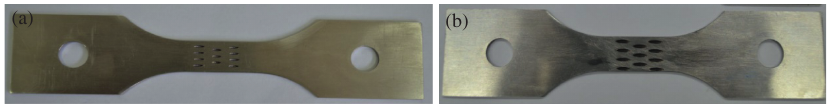
Figure 2: The specimen map: (a) electric spark drilling and (b) laser drilling.